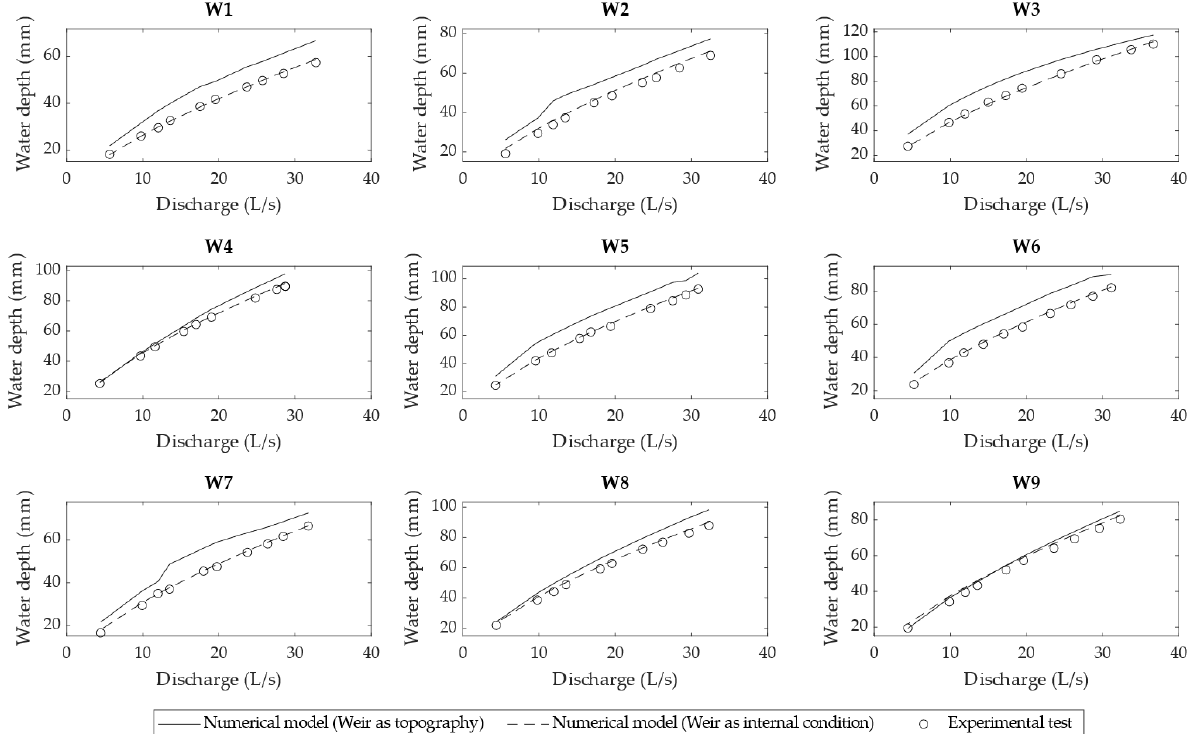
Figure 8. Comparison of discharge curves obtained with the numerical model (Iber) and the experimental tests (first experimental set). Water depth refers to the value above the weir crest level and was measured at the control point (CP) .